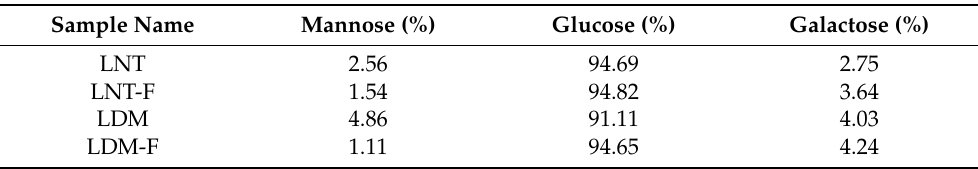
Figure 2. The HPLC chromatogram of monosaccharide standards and samples. Table 2. Monosaccharide composition of lentinan samples.